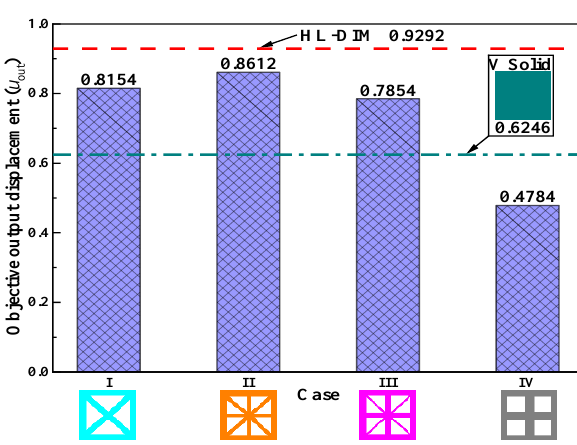
Figure 7. Objective output displacement comparison for different DIMs.